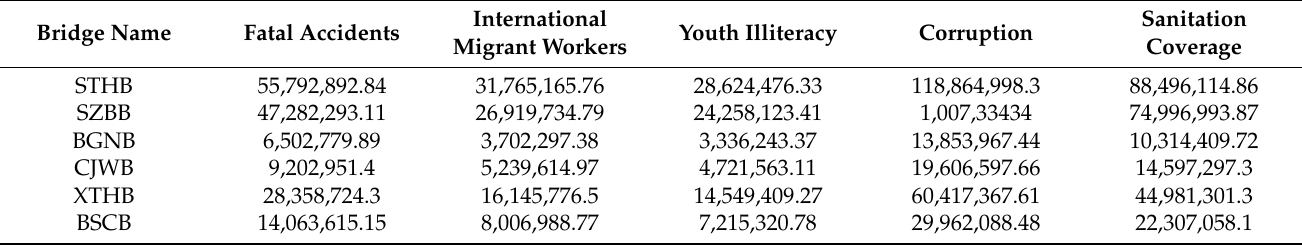
Table 9. Statistical table of five social environmental impact data for 6 cable-stayed bridges. Unit: med risk hours.